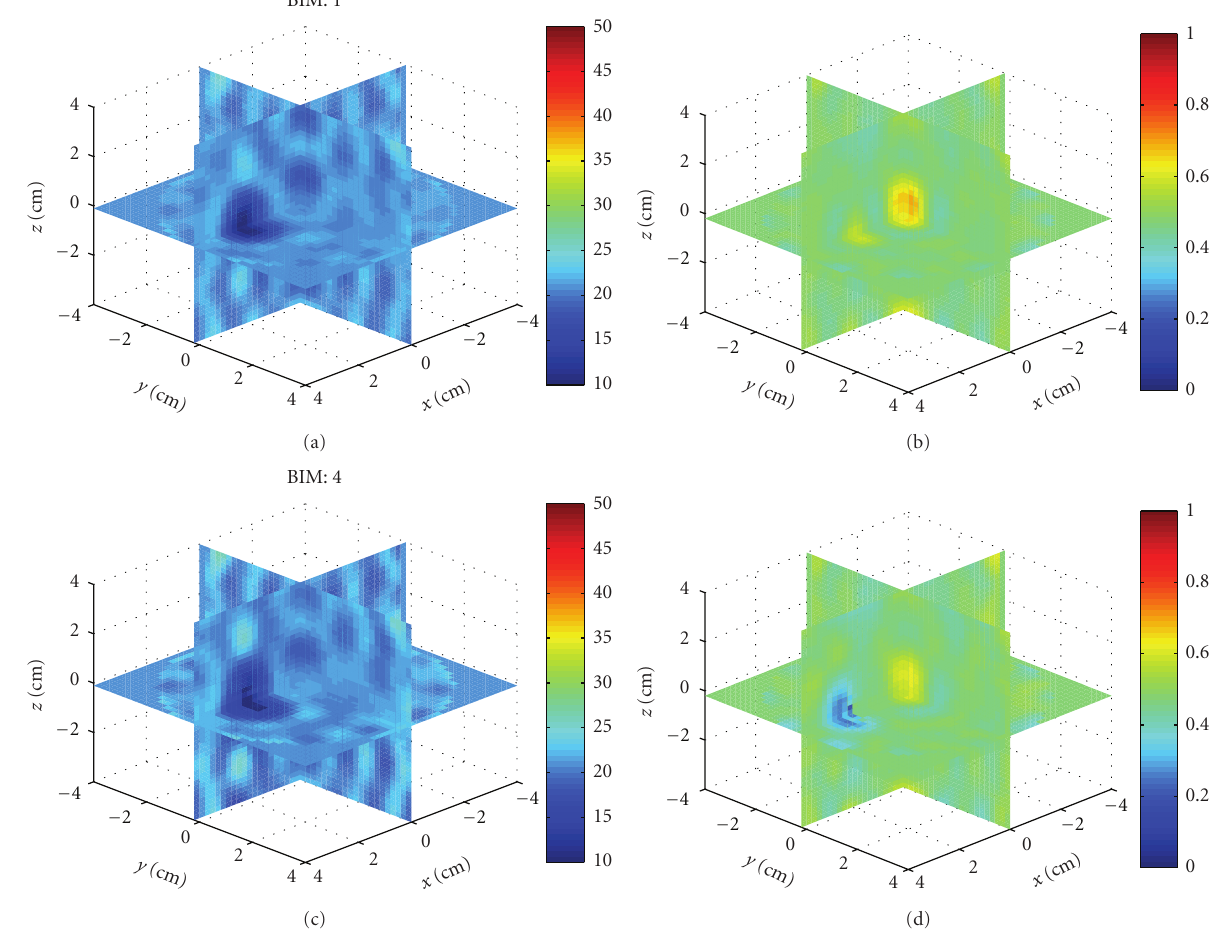
Figure 13: Reconstructions of a single sphere ( (cid:2) r , σ ) = (40, 0) located at ( x , y , z ) = (0,0,2 cm) of Example 1. Born iterations helped bring out the proper conductivity value in